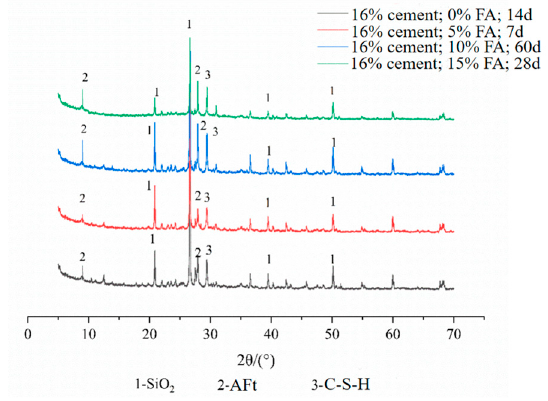
Figure 14. XRD diffraction pattern of cement–FA-modified soil.